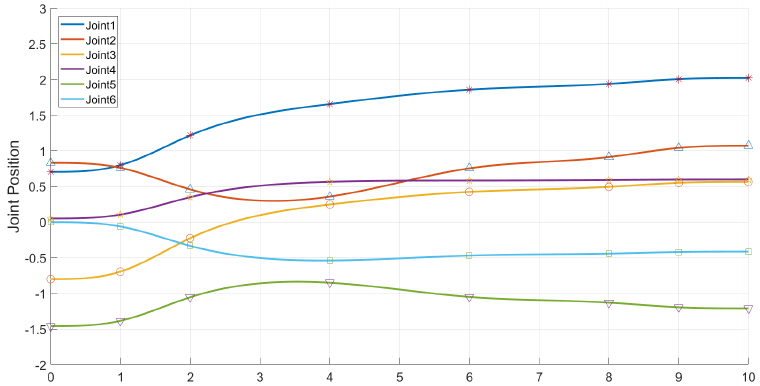
Figure 15. The joint position change curve of the AUBO − i5 when performing the placement